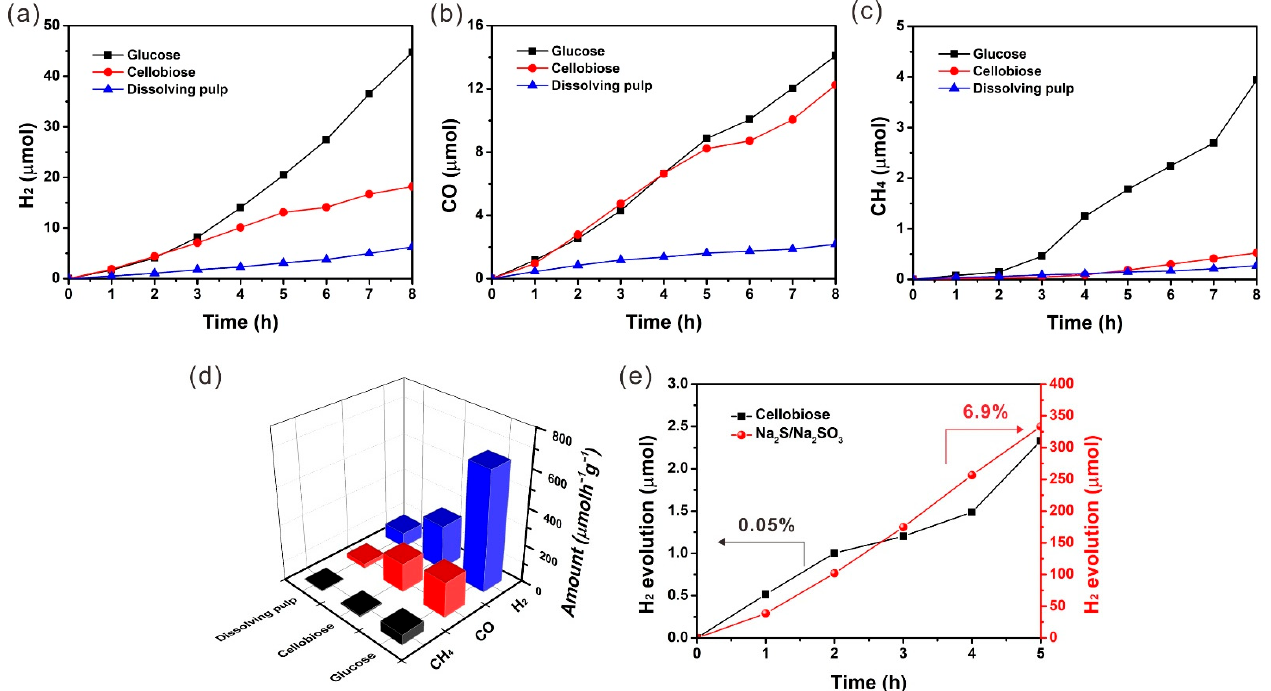
Figure 5. The amount of ( a ) H 2 , ( b ) CO, and ( c ) CH 4 as a function of the reaction time for different substrates (glucose, cellobiose and dissolving pulp); ( d ) experimental generation rates per catalyst weight of different gaseous products; ( e ) H 2 evolution amount under 450 nm monochromatic light in the presence of cellobiose and 0.25 M Na 2 S/0.35 MNa 2 SO 3 as the sacrificial agent. The percentage values in the figure are the corresponding apparent quantum yields. Reaction conditions: 10 mg photocatalyst, 15 mL 2 g/L aqueous solution with different substrates, and a 300 W xenon lamp. The hydrogen production is triggered by the proton reduction reaction of photogen- erated electrons. In a neutral condition, the produced hydrogen is mainly from glucose